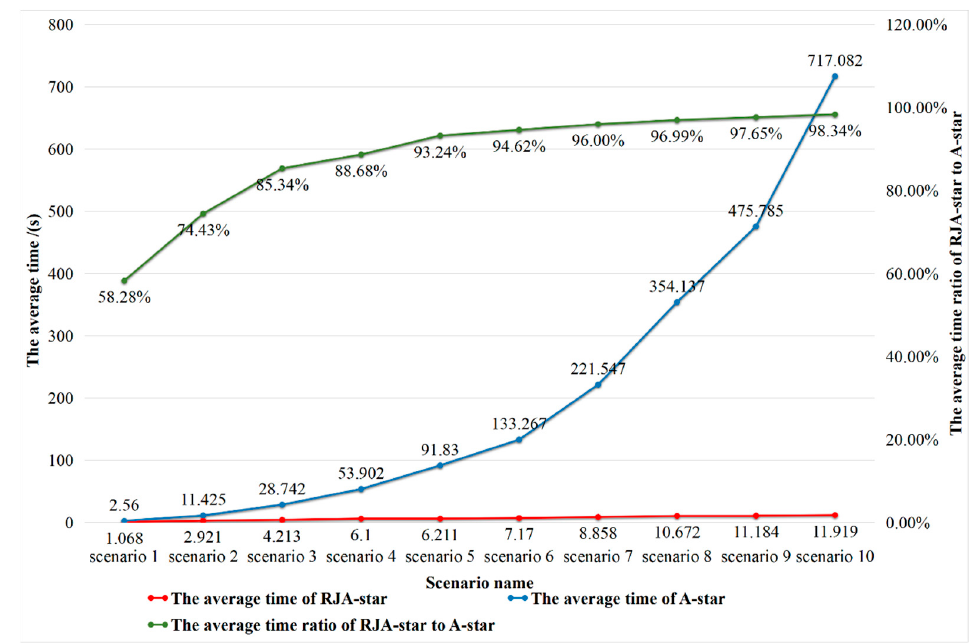
Figure 10. Comparison of the average time of the two algorithms.